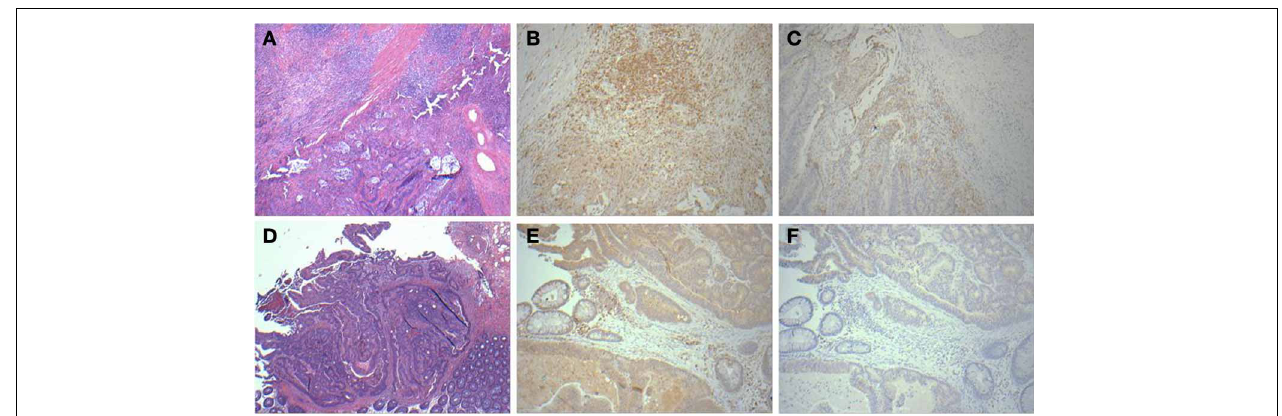
FIGURE 9 | Histopathological staining showing enhanced infiltration in relapse-free cases. HandE (A) , CD3 (B) and CD8 (C) for sample A579 (relapse-free) showing prominent lymphoid component which is T-cell (CD3) and also showing CD8 positive cytotoxic T-cells surrounding